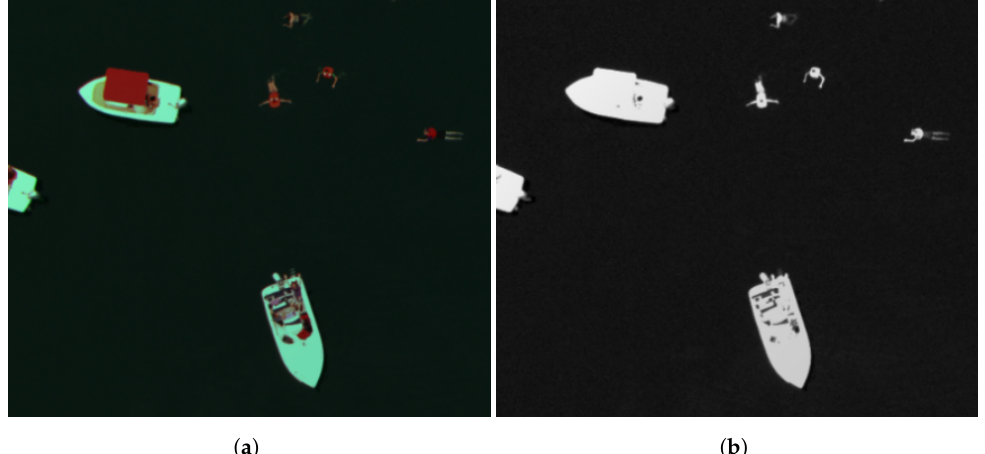
Figure 4. Example images for multispectral recordings in maritime environment. In the NIR record- ings, the swimmers are fully visible. ( a ) RGB; ( b )